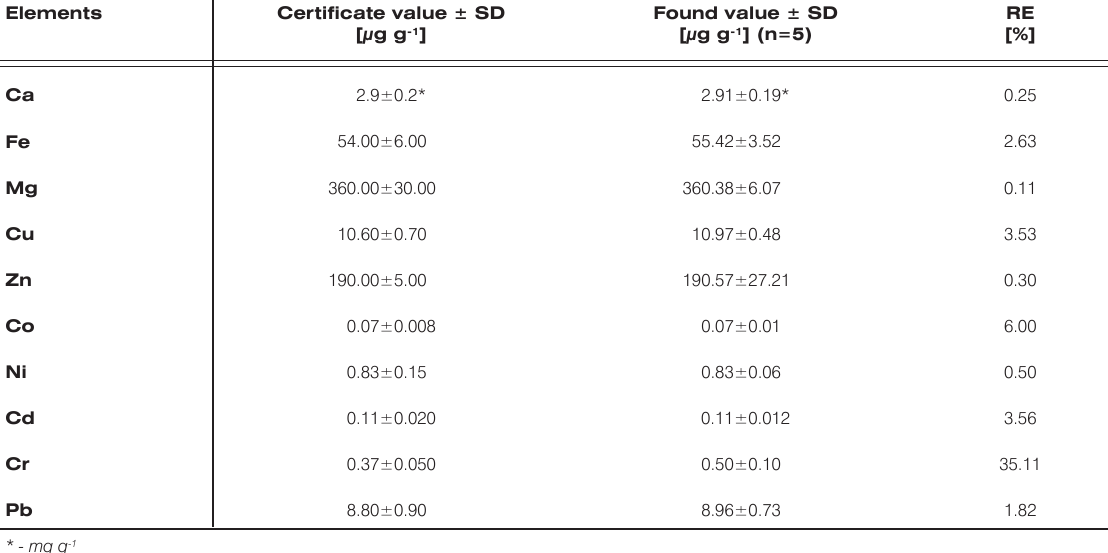
Table 2. Accuracy of ICP methods (Certified Reference Material of Human Hair (GBW07601)).